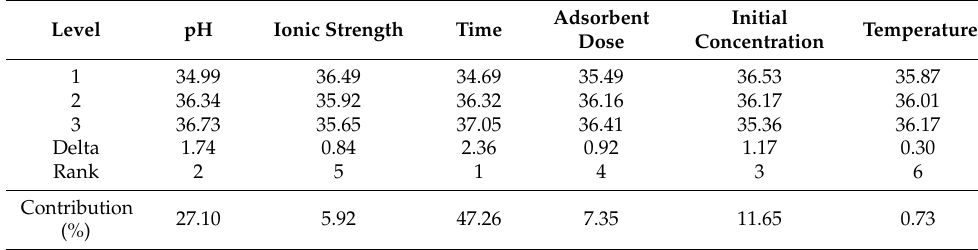
Table 6. Response table for signal-to-noise S/N ratios (larger is